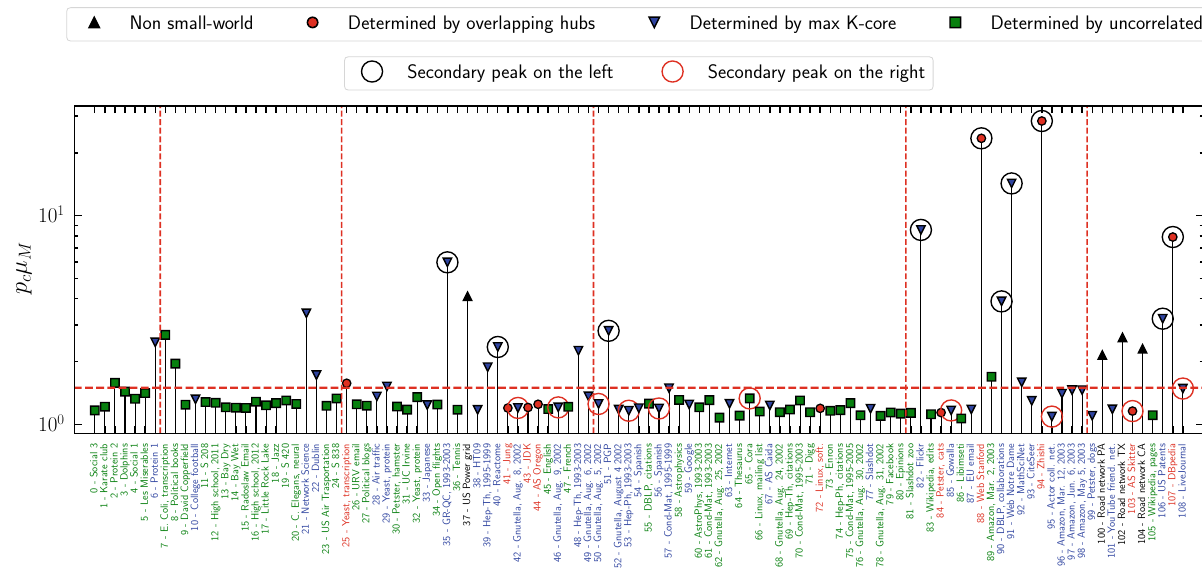
Figure 4. Test of message-passing prediction for bond percolation threshold in real-world networks. The bond percolation threshold p c determined numerically from the main peak of the susceptibility is divided by the message-passing prediction [Eq. (12)] and plotted for the 109 real-world networks considered. Below the horizontal dashed red line the prediction is accurate within 50% . Vertical dashed lines represent the size scale of the networks: from left to right N = 10 2 , 10 3 , 10 4 , 10 5 , and 10 6 . Symbols show which of the terms in Eq. (11) is maximal. Symbols are surrounded by a black (red) circle in case a secondary peak appears in the susceptibility on the left (right) of the main